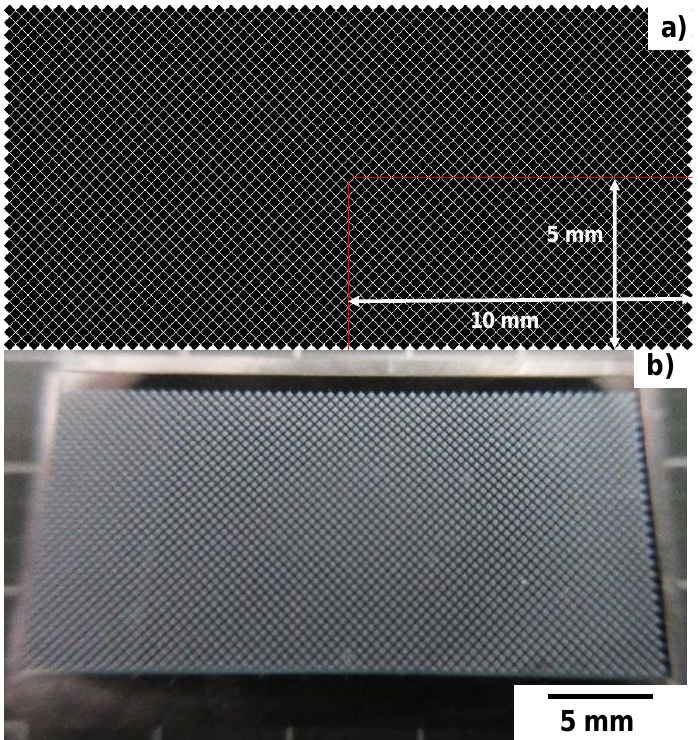
Figure 5. Micro-patterned AISI316 die substrate by the screen printing. ( a ) Micro-pattern on the screen corresponding to the CAD data and ( b ) the printed micropattern on the AISI316 die substrate.